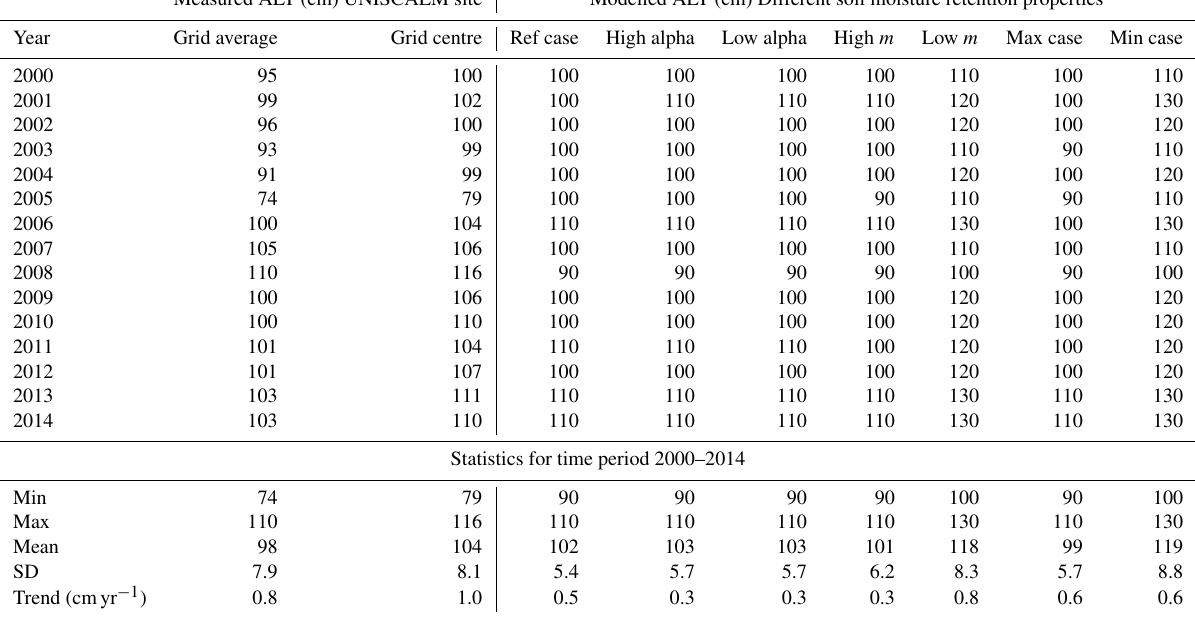
Table 5. Active layer thickness (ALT) for the study period 2000–2014 and corresponding statistics, as measured at the UNISCALM grid (average of all grid points and also the centre location, which is nearest the temperature logger) and as obtained from